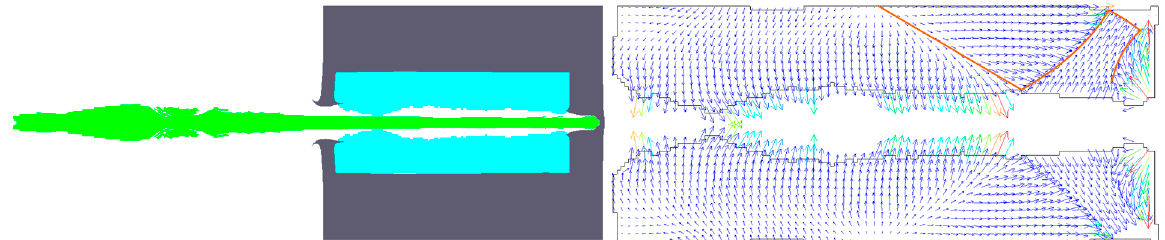
Figure 10. Generation and propagation of the bottom plate reflection shock wave. The bottom plate reflection wave is reflected from the side wall to form a secondary reflection wave. The secondary reflection wave propagates in the liquid until it reaches the liquid crater wall to drive the liquid to converge and disturb the jet. Figure 11 depicts that the upper part of the liquid converged to contact with the jet surface, and the jet carried out the secondary impact on the reflux liquid. However, the crater diameter of liquid secondary reaming is small due to the decrease in the jet impact pressure and the existence of liquid motion inertia, which is ignored in the calculation.